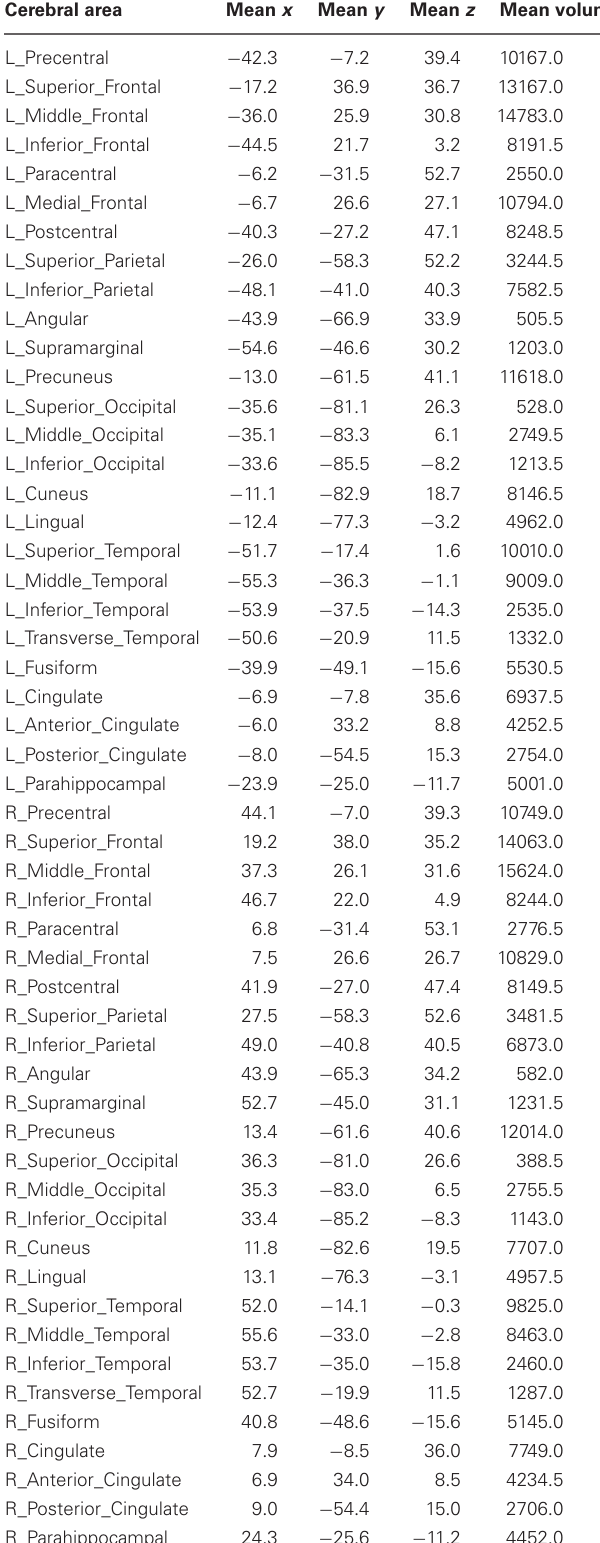
Table 1 | Mean x-, y- and z -Talairach coordinates and mean volumes (mm 3 ) of 52 areas of the cerebral cortex of 18